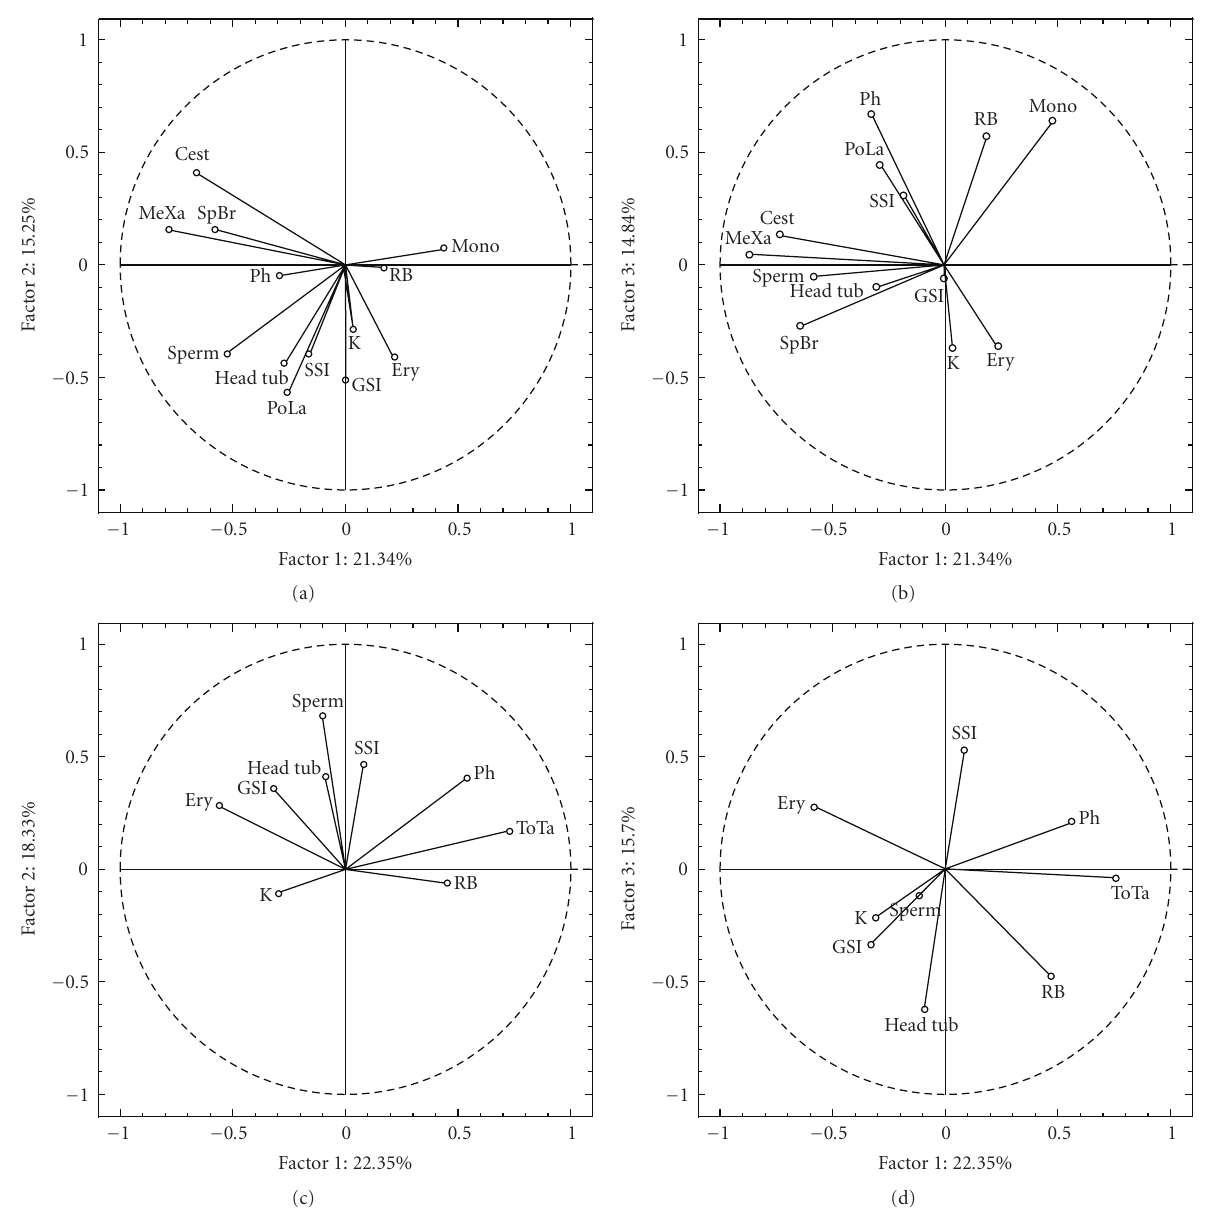
Figure 3: Principal component analysis (PCA) to evaluate the associations within physiology, immunity, and parasitism in breeding period. For abbreviations see legend of Figure